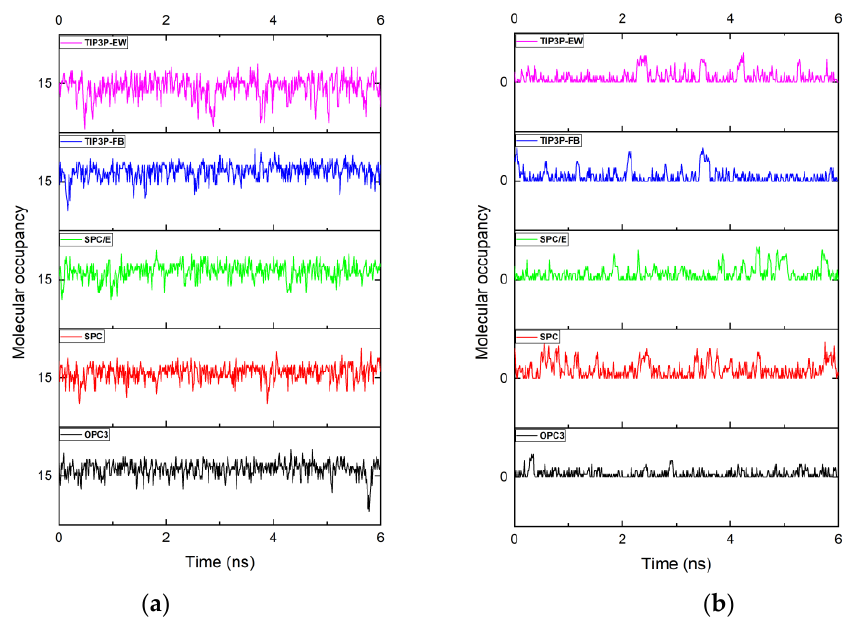
Figure 4. Number of water molecules inside the ( a ) multilayered non-functionalized porous graphene and ( b ) multilayered functionalized porous graphene using different water models at a given time.